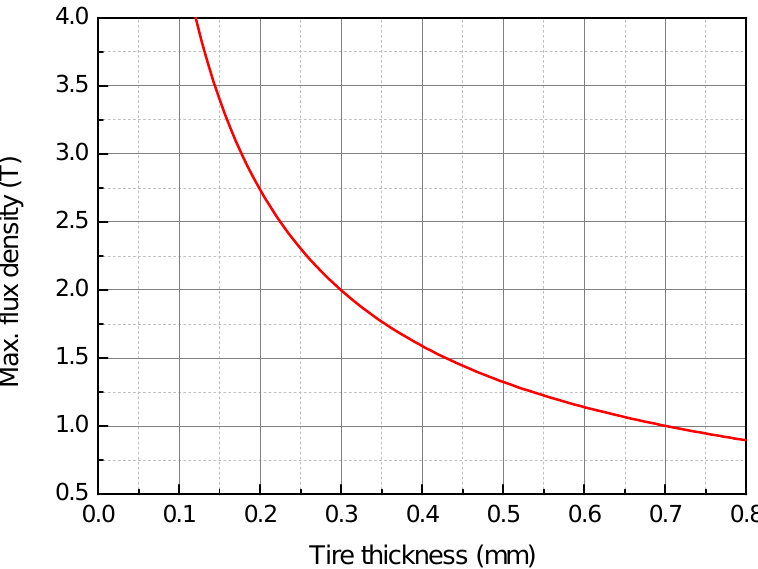
Figure 9. Maximum flux density in the air gap between the wheel and the surface, calculated by the force